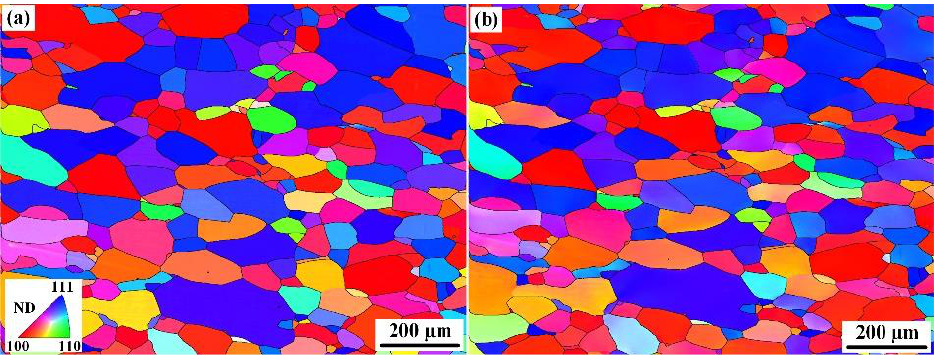
Figure 3. The tracking orientation imaging maps (OIMs) of the specimen before and after deformation. ( a ) OIM before deformation, ( b ) OIM of the same area after deformation.